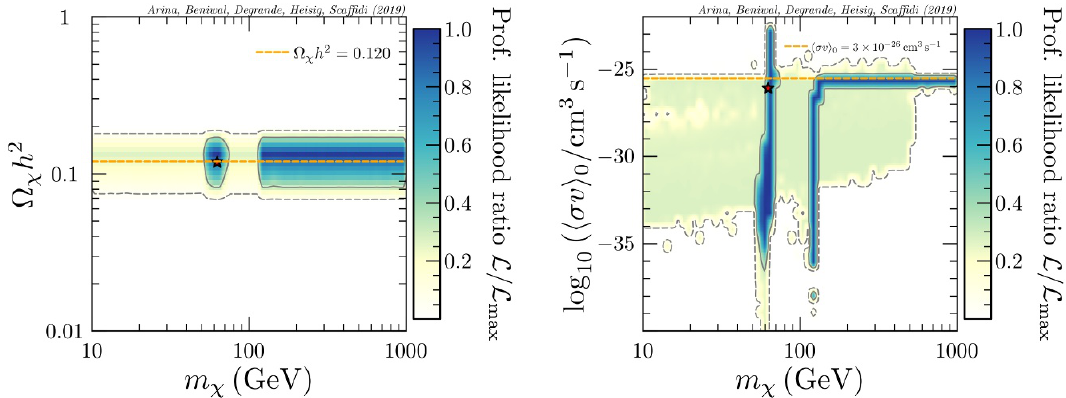
2 ( left panel ) (cid:31) h